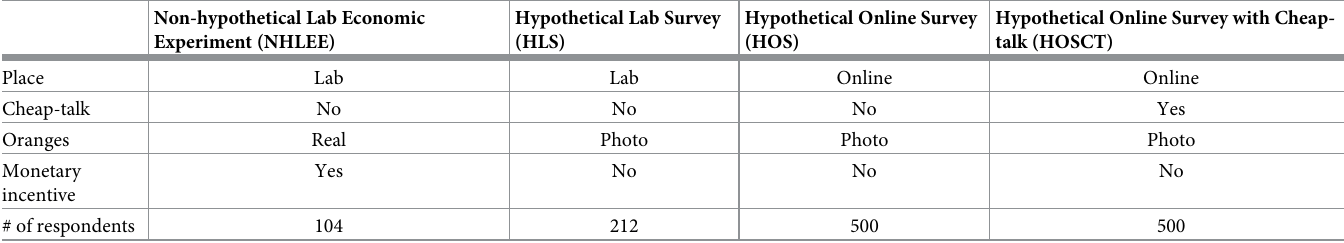
Table 2. The characteristics of